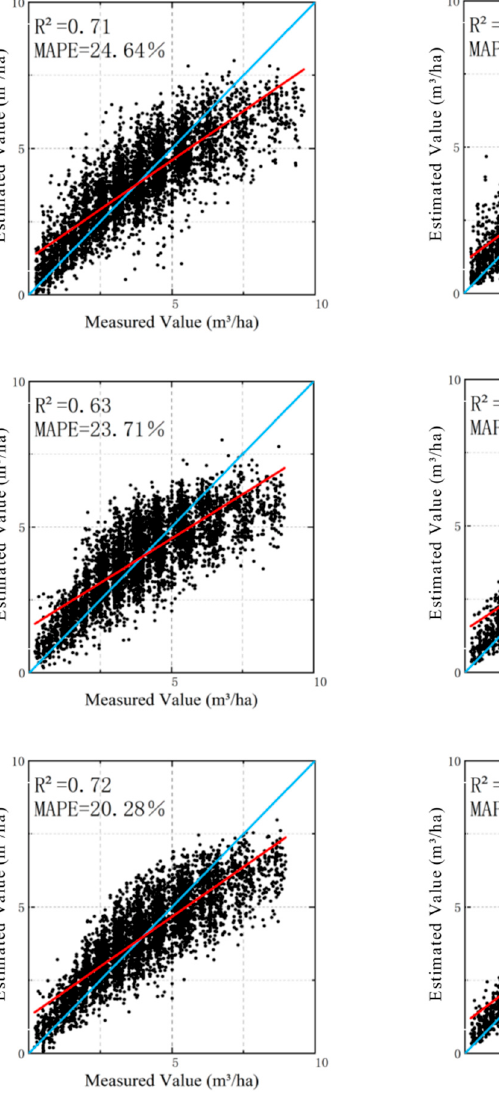
Figure 6. Scatter plot between the estimated values and measured values of forest growing stock based on models GBDT, XGBoost, and CatBoost. ( a ) Without category features, with single remote sensing data; (a1) GBDT, (a2) XGBoost, (a3) CatBoost. ( b ) With category features, with single remote sensing data; (b1) GBDT, (b2) XGBoost, (b3) CatBoost. ( c ) Without category features, with multi- source remote sensing data; (c1) GBDT, (c2) XGBoost, (c3) CatBoost. ( d ) With category features, with multi-source remote sensing data; (d1) GBDT, (d2) XGBoost, (d3) CatBoost.